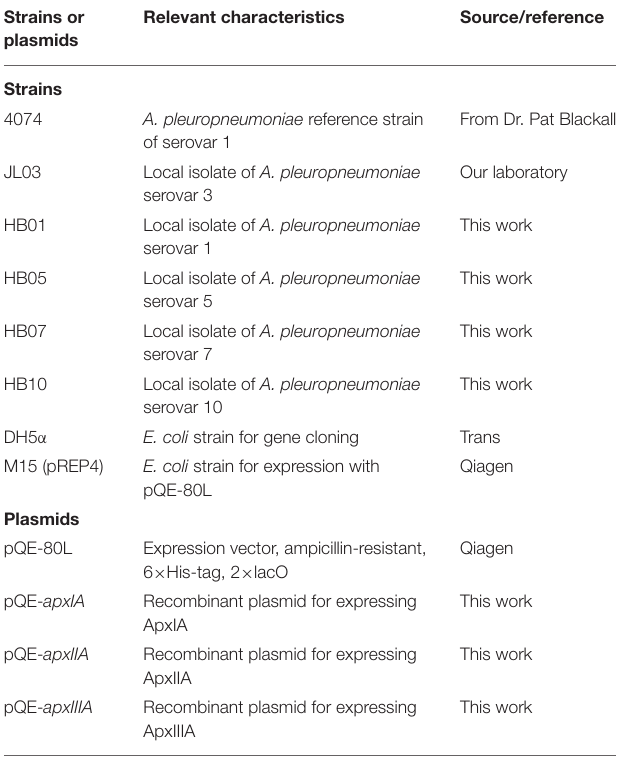
TABLE 1 | Characteristics of bacterial strains and plasmids used in this